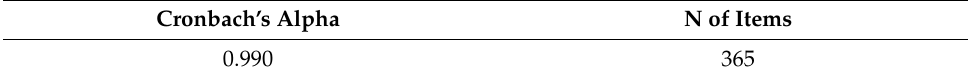
Table 7. Reliability